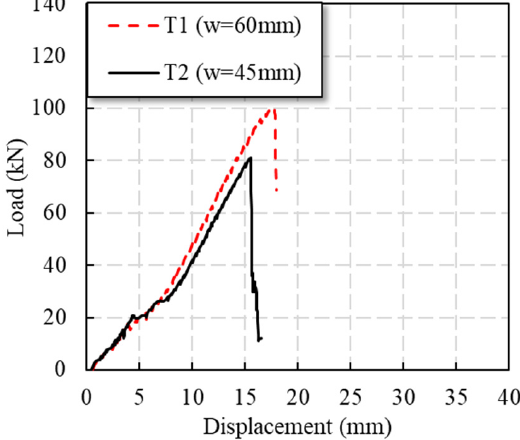
Figure 7. Load–displacement curves of specimens with different plate widths.